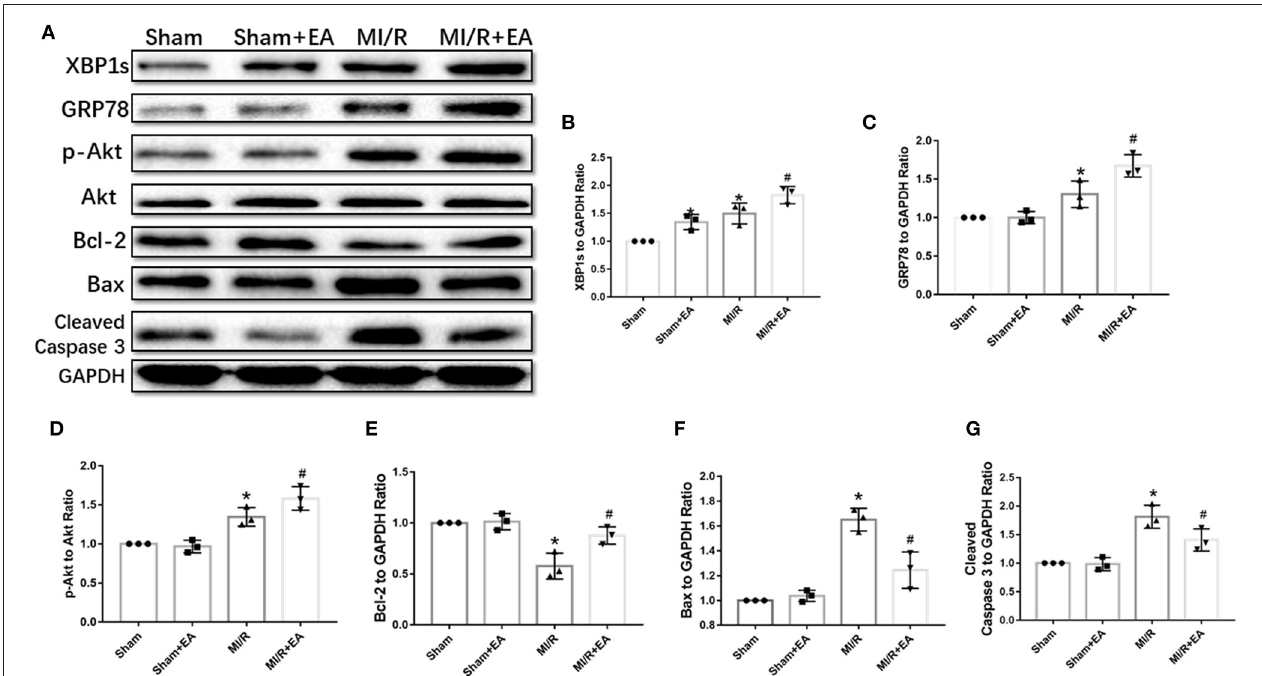
FIGURE 4 | EA pretreatment activated XBP1/GRP78/Akt pathway and reduced apoptotic protein expressions. (A) Representative blot images of proteins related to XBP1/GRP78/Akt and apoptotic signaling pathways. (B–G) The quantitative analysis of XBP1, GRP78, p-Akt, Bcl-2, Bax, and cleaved Caspase 3 protein expressions. n = 3 in each group. * P < 0.05 vs. Sham group, # P < 0.05 vs. MI/R group. EA, electroacupuncture; MI/R, myocardial